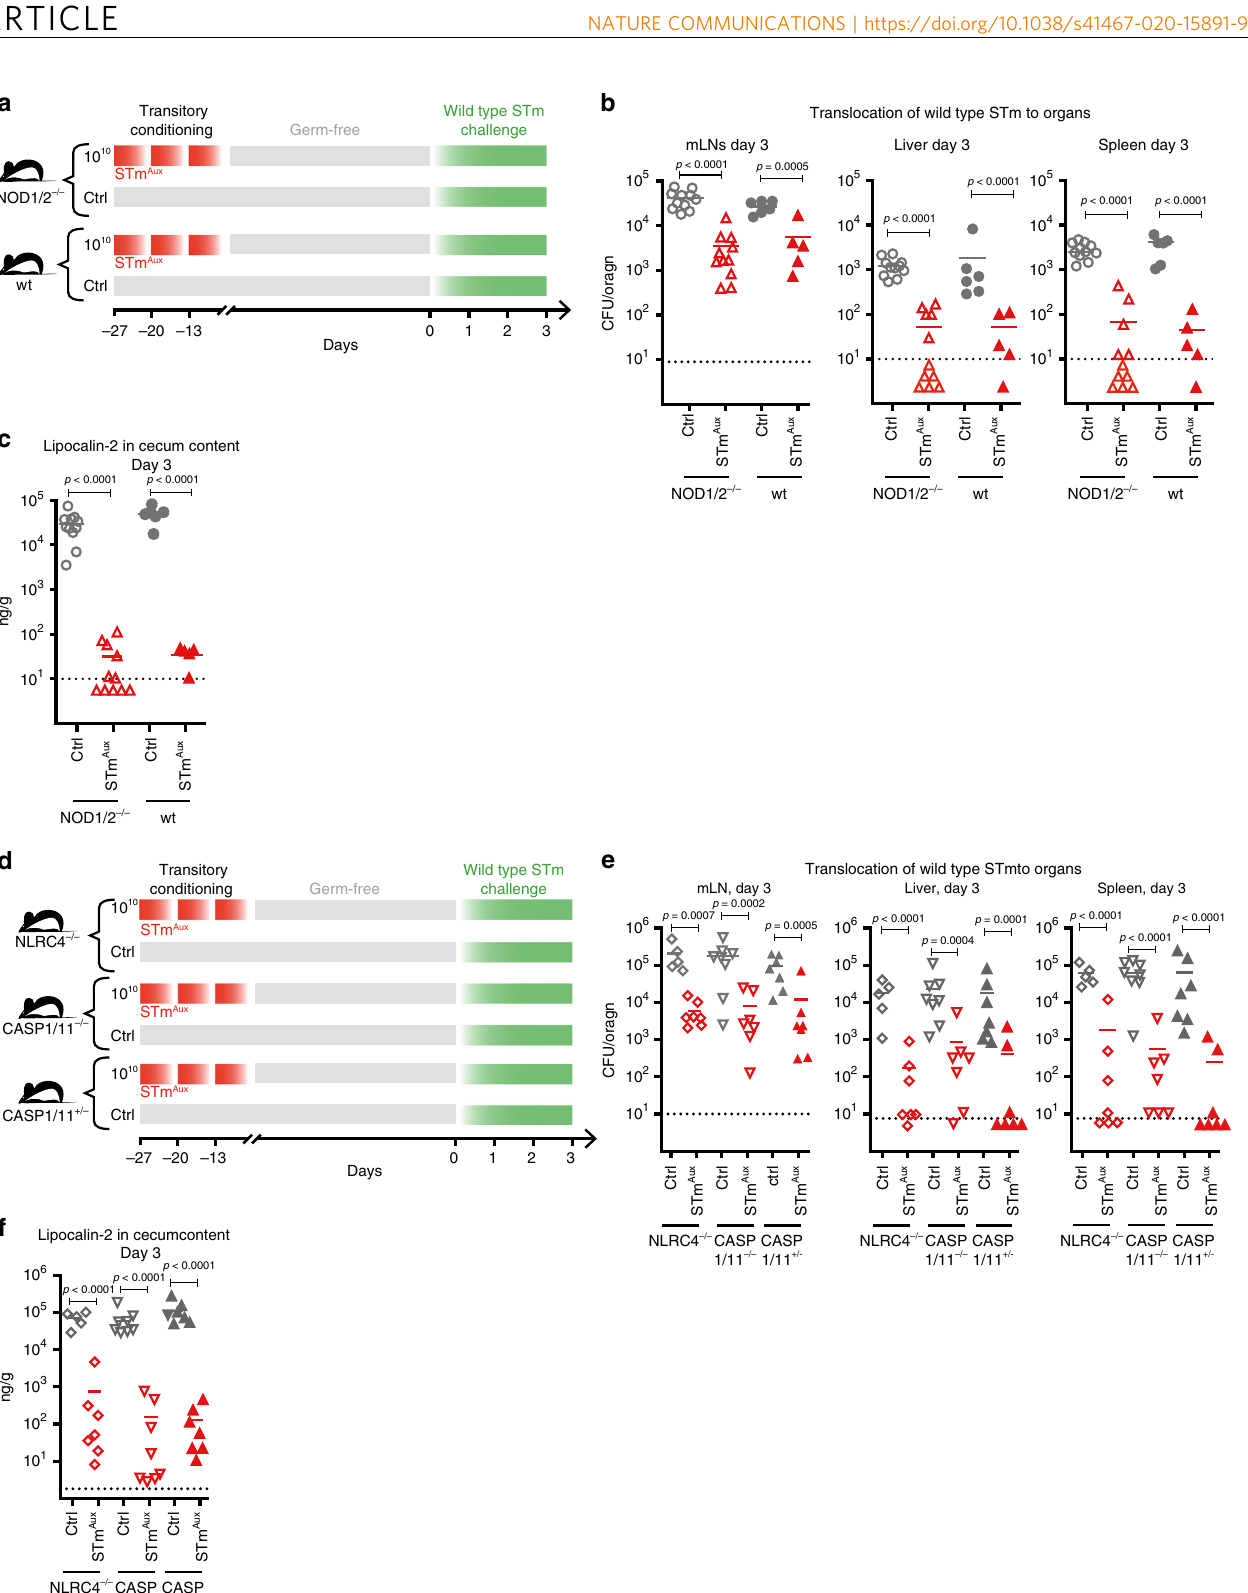
used mouse model for nontyphoid invasive salmonellosis 9,24,40 , immunity synergizes with niche competition by STm Aux in protection against wild-type STm challenge. Measurements of were also permissive for extended gut luminal colonization of cecal luminal lipocalin-2 and challenge bacterial burden in mLN, STm Aux (Supplementary Fig. 13C). These data show that in the colonized mouse model, microbiota- liver, and spleen at day 4 of wild-type STm challenge support this syntrophic STm Aux more closely mimics the natural pathogen in conclusion (Fig. 7i, j, Supplementary Fig. 14D). In a second context, streptomycin pre-treated conventional mice, a widely terms of intestinal luminal colonization and virulence factor-driven NATURE COMMUNICATIONS| (2020) 11:1978